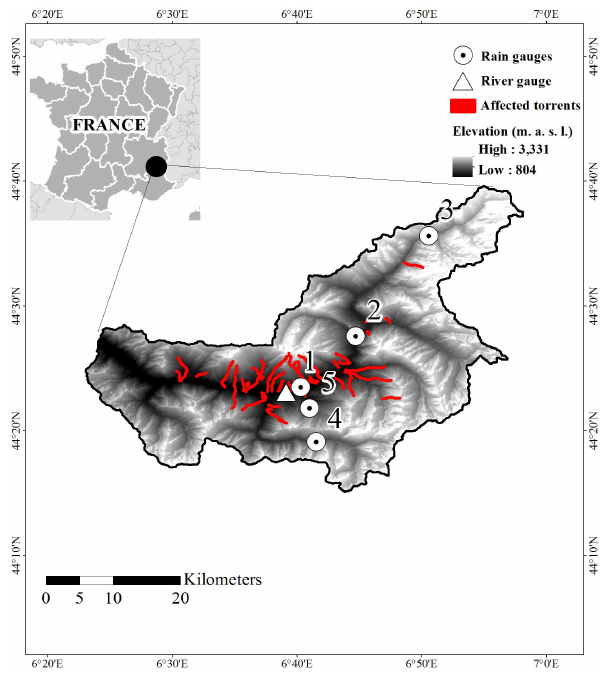
Figure 1. The study area including the location of rain gauges and a single river gauging station. Red lines depicts the affected torrents where debris flows or flash floods occurred between 1979 and 2010 (map based on Breinl et al.,